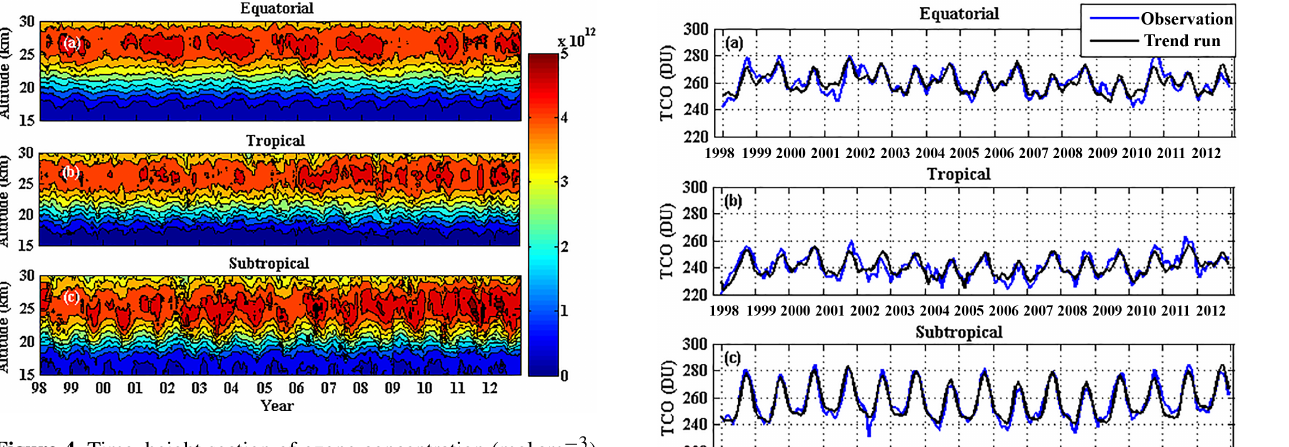
Figure 4. Time–height section of ozone concentration (molcm − 3 ) obtained by mean monthly profiles recorded over stations located in the equatorial (a) , tropical (b) and subtropical (c) regions from January 1998 to December 2012. Table 3. Time period and total number of height profiles used in this analysis for selected stations.